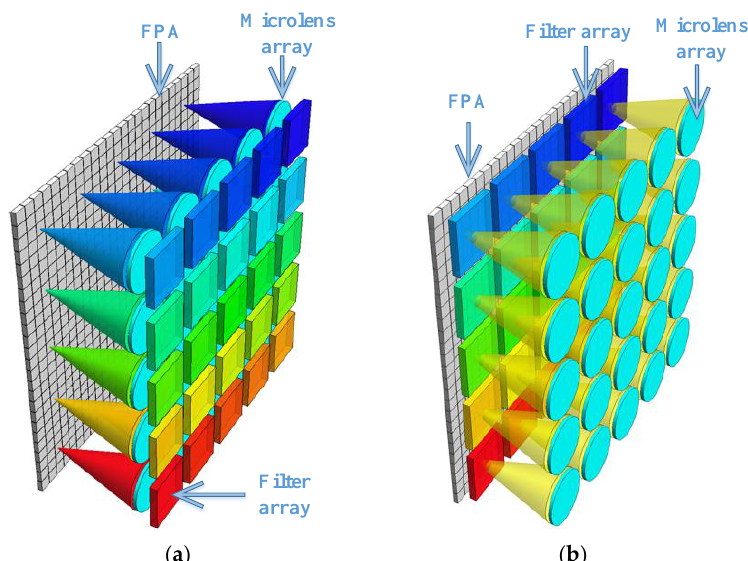
Figure 3. Diagram of planar snapshot MSI system’s structure. ( a ) The filter array placed in front of the MLA. ( b ) The filter array placed behind the MLA.